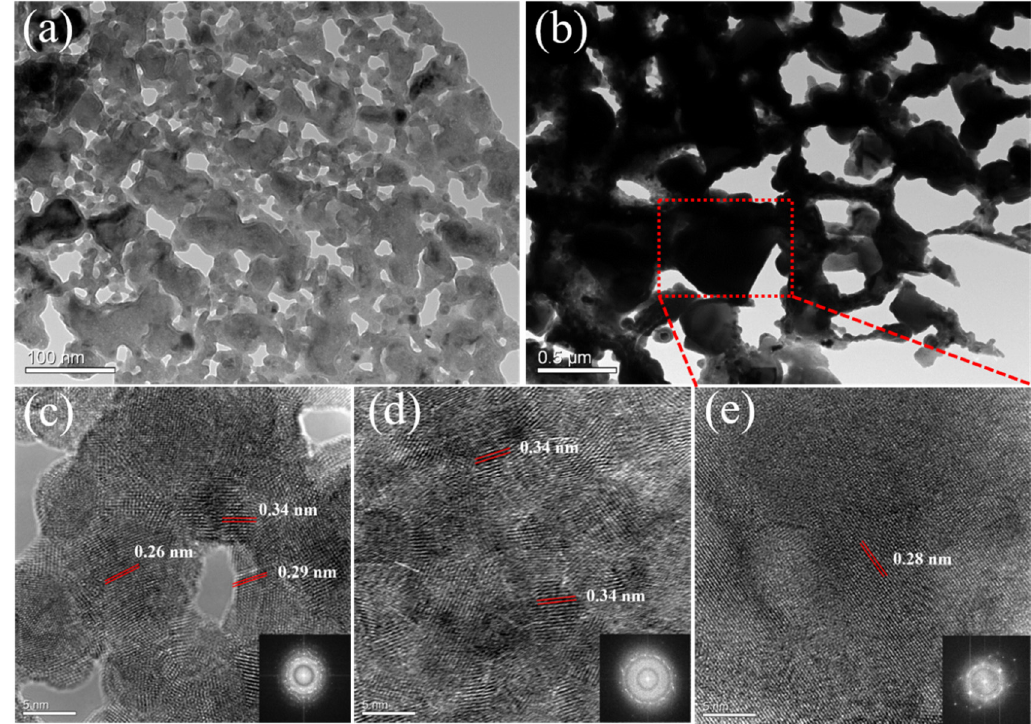
Figure 3. TEM images of dealloyed ( a ) Mg 67 Cu 18 Sn 15 and ( b ) Mg 66 Cu 10.2 Sn 23.8 ; HRTEM of dealloyed ( c ) Mg 67 Cu 18 Sn 15 , ( d ) ligament domain and ( e ) particle domain of Mg 66 Cu 10.2 Sn 23.8 . Insets of ( c – e ) are the corresponding FFT patterns.